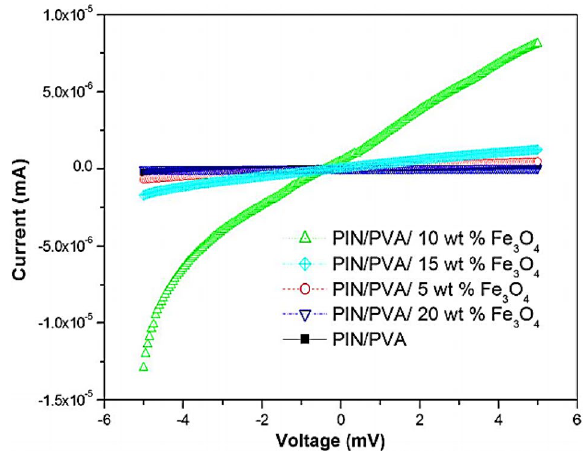
Fig. 9 Effect of Fe 3 O 4 nanoparticles on DC conductivity of PIN/PVA blend [13]